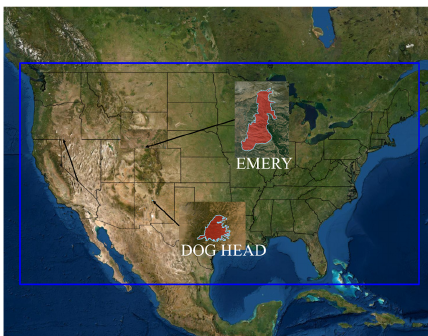
Figure 14. The map of two wildland fires used for validating the scalability of the proposed model.